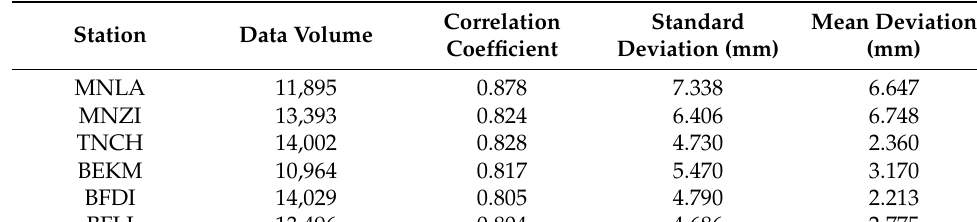
Table 2. Comparative analysis of PWV and TCWV.